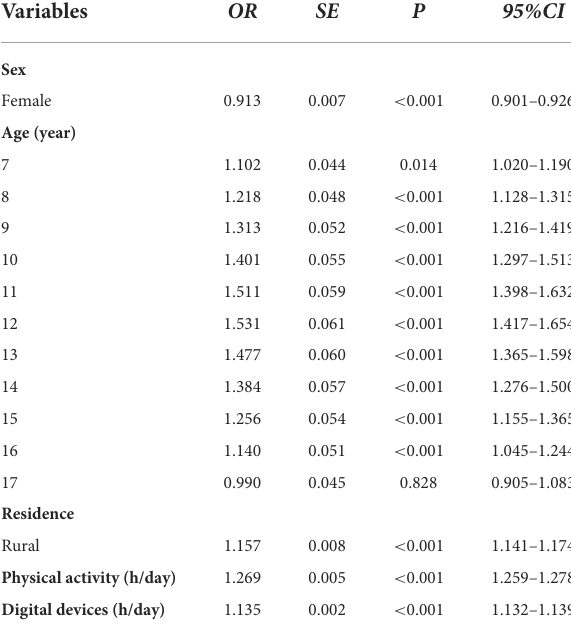
TABLE 1 The poor visual acuity of children and adolescents during the COVID-19 pandemic.